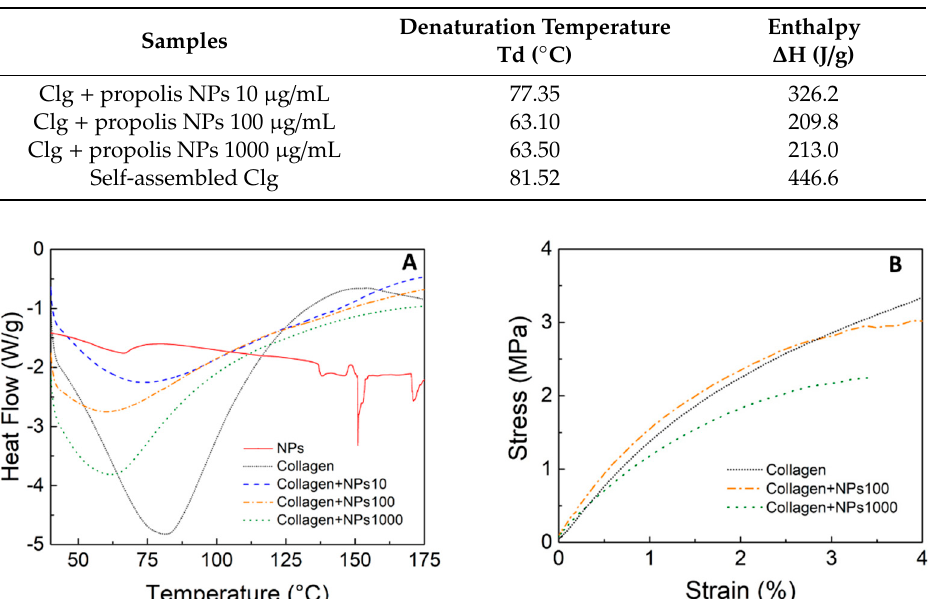
Summary of the denaturation temperature and enthalpy of collagen with di ff erent concentrations of nanoparticles calculated from the DSC curves. Clg = collagen sca ff old. The enthalpy values were calculated as the integrated area under the peak divided by the mass of the sample.